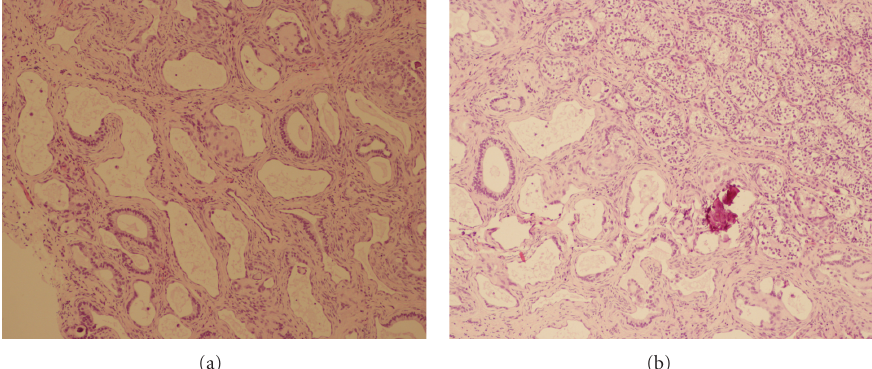
Figure 3: Histological examination showing (a) multiple, anastomosing, irregular cystic spaces of varying sizes and shapes, (b) pushing normal parenchyma toward